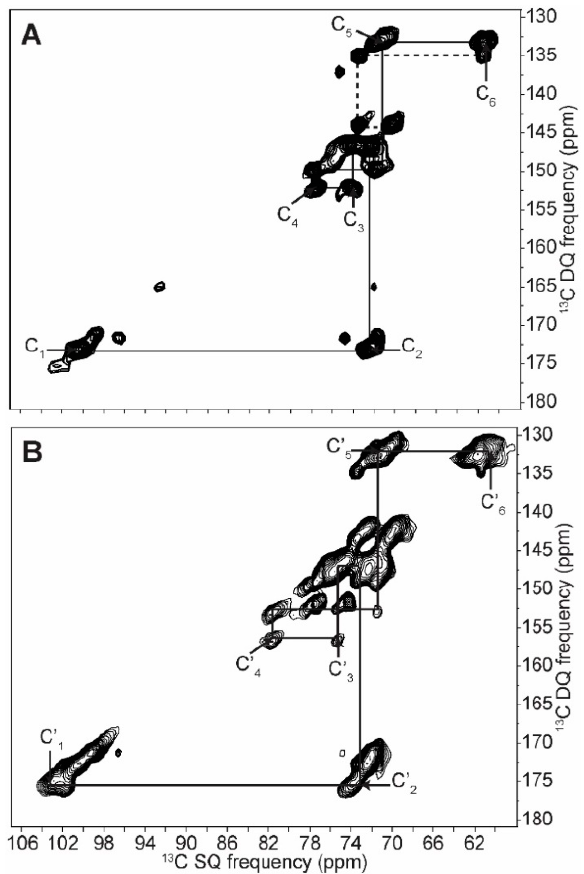
Figure 3. 2D INADEQUATE 13 C ssNMR spectra based on: NOE ( A ) and CP ( B ) for native starch (A- polymorph). Continuous lines indicate the correlation between the crystalline domains represented in ( A ) and the amorphous domains represented in ( B ), while dashed lines indicate end groups. Adapted with permission from Ref. [76]. Copyright 2018, MDPI.